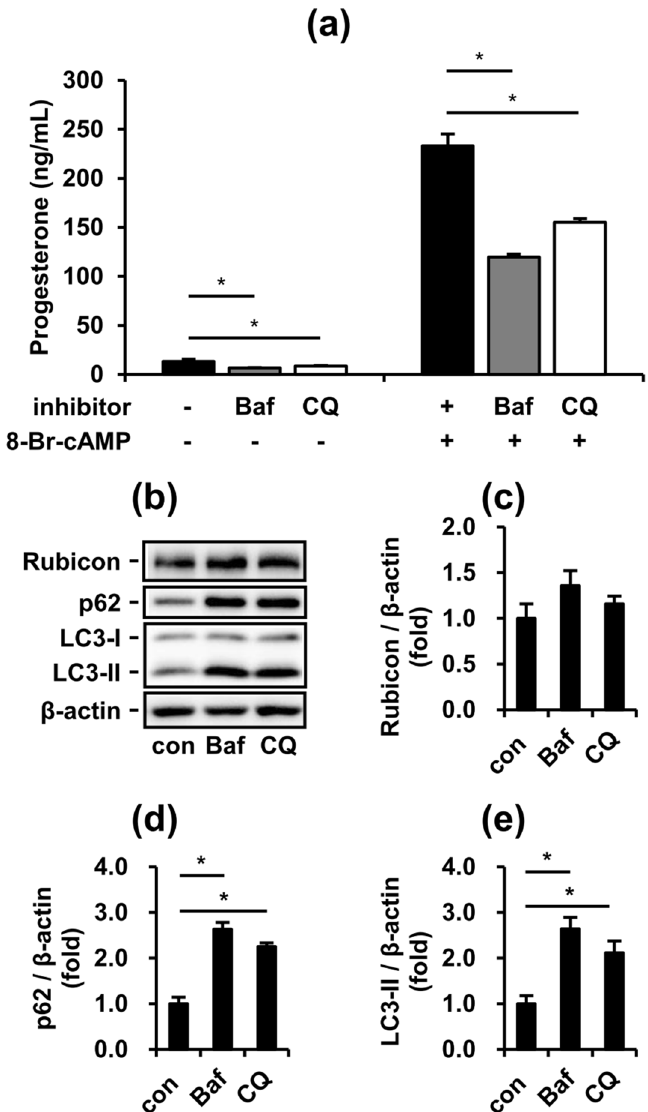
Figure 6. Inhibition of autophagy suppresses both basal and stimulated steroidogenesis of MA-10 cells. To further investigate the effects of inhibited autophagy in MA-10 cells, we applied two late-stage autophagy inhibitors, bafilomycin A1 (Baf) and chloroquine (CQ). After treatment with or without 50 nM Baf and 20 µM CQ for 24 h, the conditioned medium and cell lysates from cultured MA-10 cells were collected for further analysis. ( a ) Progesterone levels in condition medium from the assigned groups of MA-10 cells. ( b ) Representative blots of autophagy markers in cultured MA-10 cells. ( c ), ( d ), ( e ) Quantifications normalized by β-actin are shown as means ± SEM (n = 4). *P <